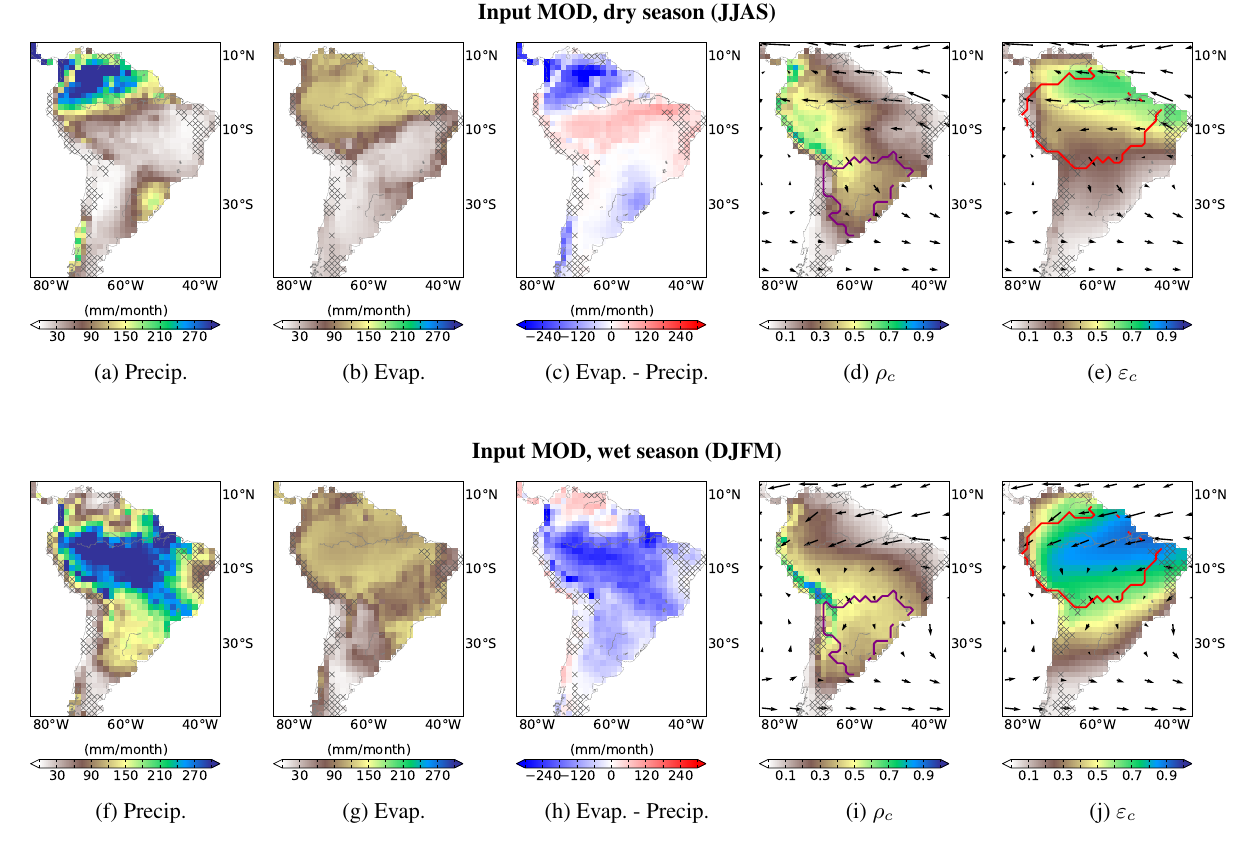
Fig. 1: WAM-2layers input and output as calculated for the period 2001 – 2010 for MODIS and TRMM (input MOD, see Table 1): long-term seasonal mean of precipitation (a, f) , evapotranspiration (b, g) , precipitation–evapotranspiration (c, h) , continental precipitation recycling ratio ρ c (d, i) and continental evapotranspiration recycling ratio ε c (e, j) indicating respective sinks and sources of continental moisture. Here and in the following figures, the vectors indicate the horizontal moisture flux field (in m 3 of moisture × m − 2 × month − 1 ) and the hatches represent grid cells where mean annual evapotranspiration exceeds mean annual precipitation. The red lines delimit the Amazon basin and the purple lines delimit the La Plata basin. Results are given for the dry season (upper row) and the wet season (lower row).